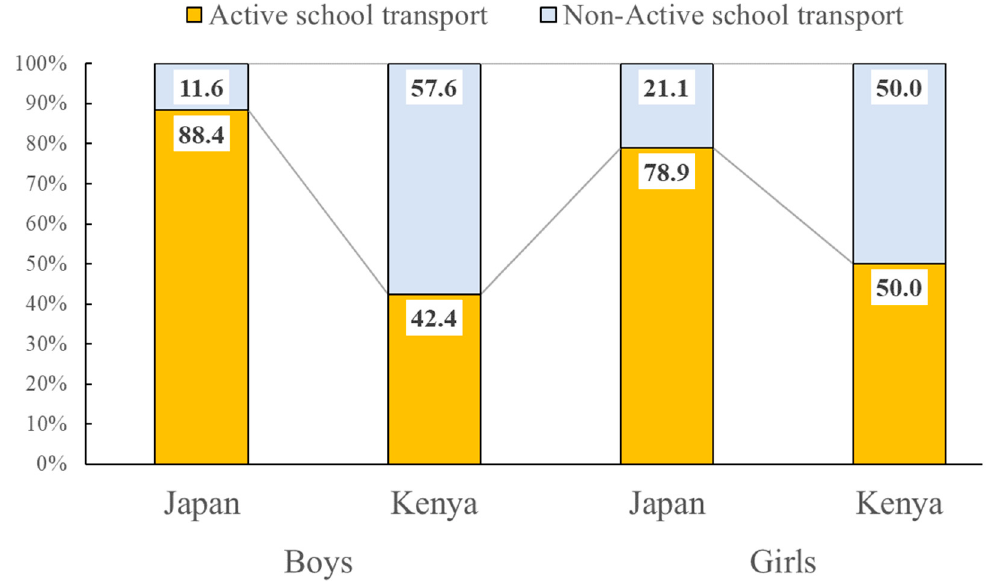
Figure 5. Proportion of children using active transport to school among Kenyan and Japanese children.